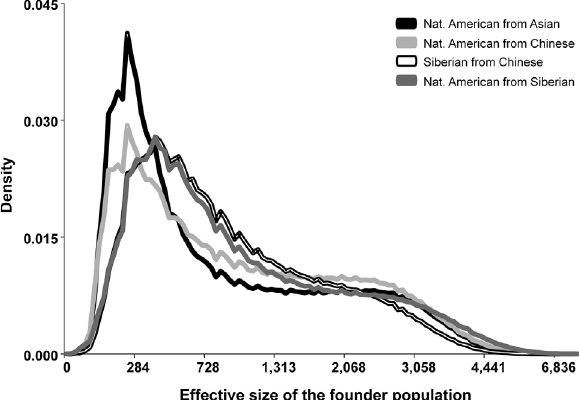
Figure 2 - Posterior densities for the effective sizes of the founder popula- tion. The size of the founder population for Native American from Asia is shown in solid black, for Native American from Chinese in light gray, for Siberian from Chinese in white with black contour, and for Native Ameri- can from Siberian in dark gray, as shown in the graphical legend.